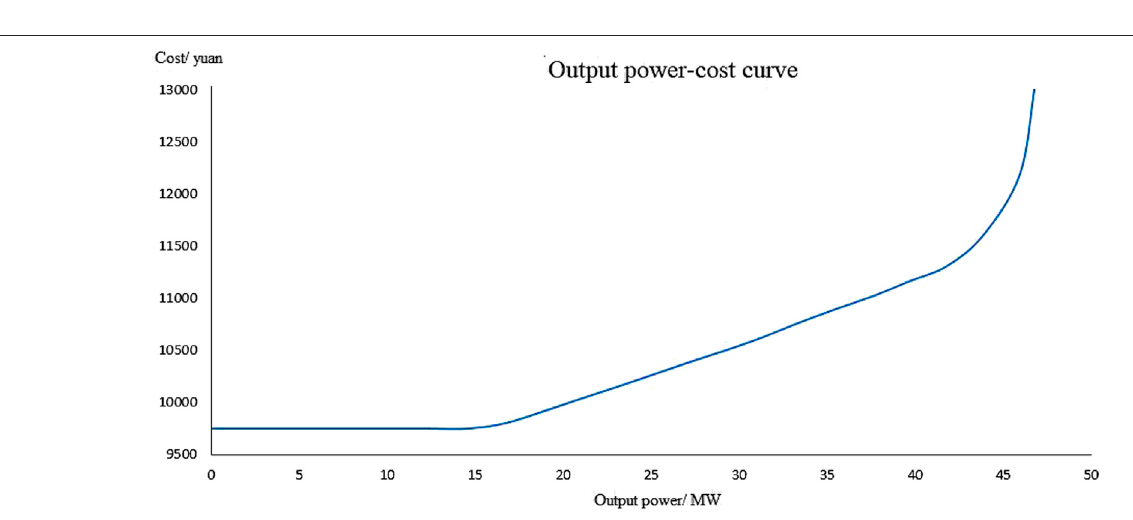
FIGURE 12 | Output power-cost curve for